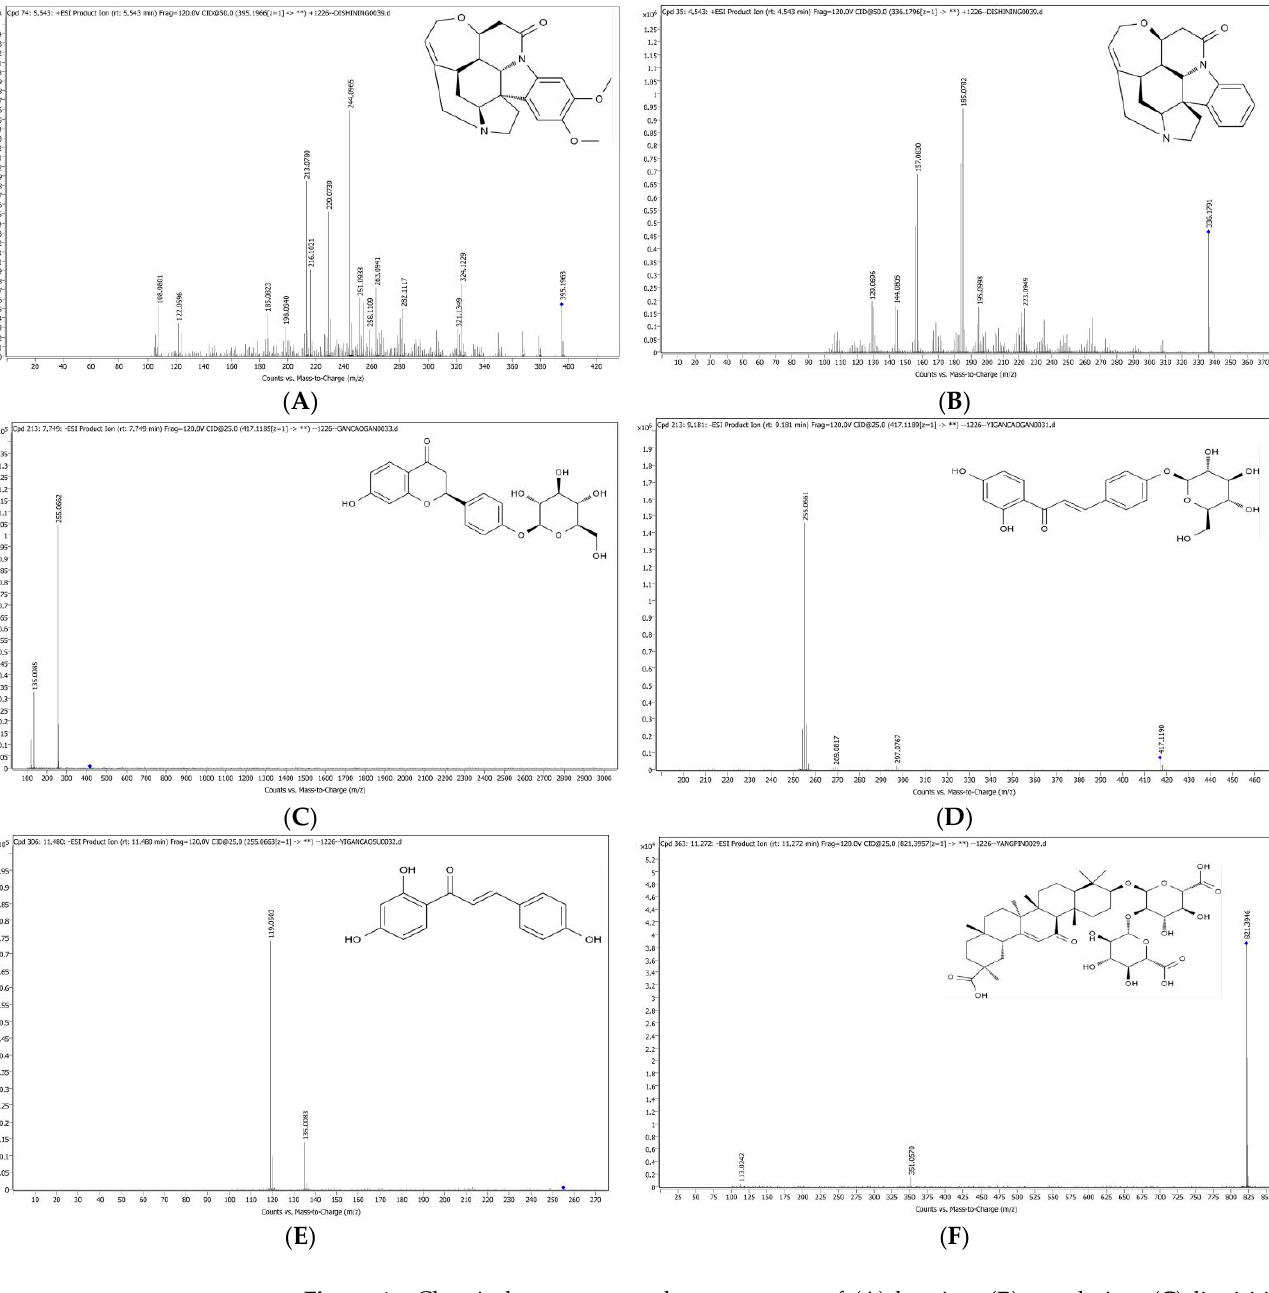
Figure 1. Chemical structures and mass spectra of ( A ) brucine, ( B ) strychnine, ( C ) liquiritin, ( D ) isoliquiritin, ( E ) isoliquiritigenin and ( F ) glycyrrhizic acid. The mobile phase consisted of solvent A (containing 0.1% aqueous formic acid) and solvent B (acetonitrile containing 0.1% formic acid). The gradient elution procedure